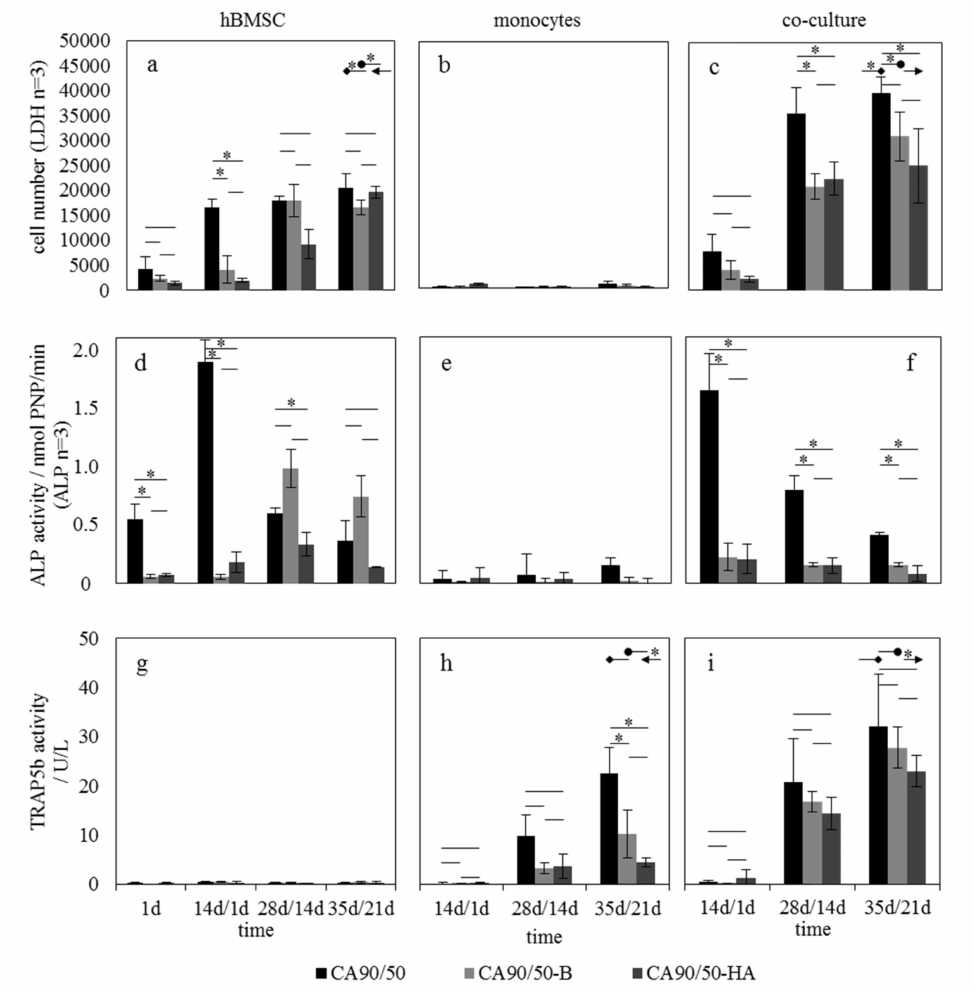
Figure 3. Cell culture analysis of chitosan sca ff olds without and with brushite and hydroxyapatite modification. Adhesion and proliferation data are presented in terms of cell numbers (LDH) in ( a ) hBMSC mono-culture, ( b ) hM mono-culture, and ( c ) co-culture. Osteogenic di ff erentiation of the cells was analyzed in terms of alkaline phosphates (ALP) activity ( d – f ), while osteoclastic ripening was measured in terms of TRAP5b activity ( g )–( i ). The arrow tails in ( a , c ) and those in ( h , i ) show the result of significance analysis for selected candidate pairs of values. An asterisk is placed at both arrow tails to indicate significant di ff erence with a p value of <